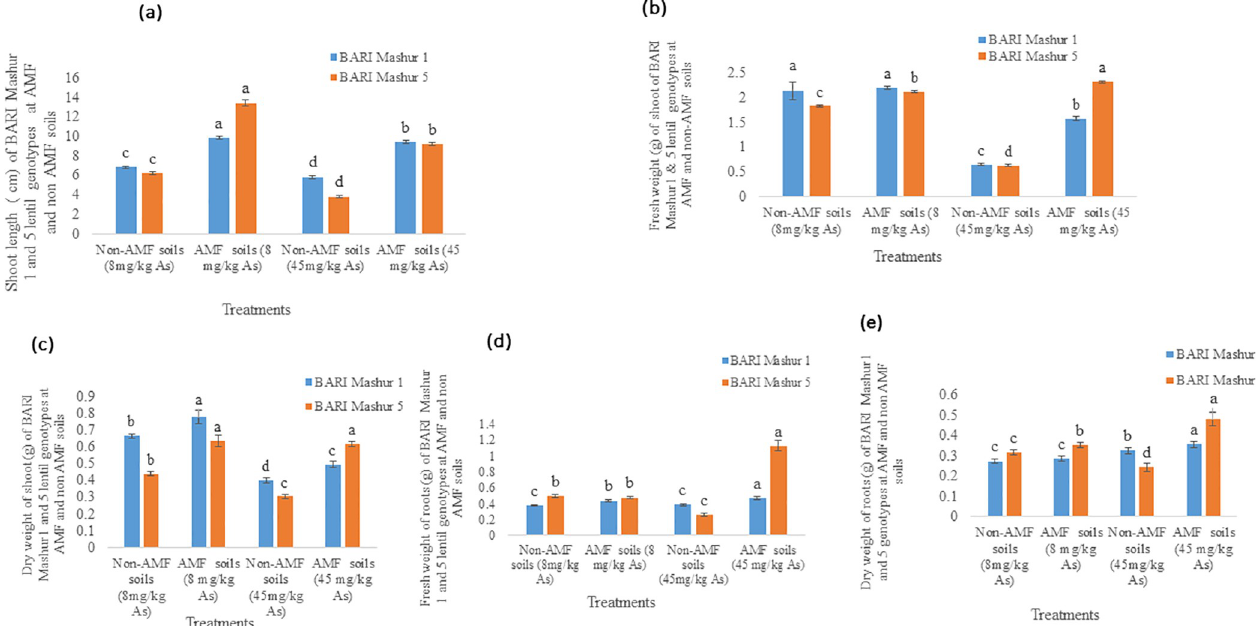
Fig 2. Effect of Arbuscular Mycorrhizal Fungus (AMF) on a) shoot length (Mean ± SEM), b) fresh weight of shoot (Mean ± SEM), c) dry weight of shoot (Mean ± SEM), d) fresh weight of roots (Mean ± SEM), e) dry weight of roots (Mean ± SEM) at arsenic treated BARI Mashur 1 & 5 lentil genotypes. Means denoted by different letters under the same As level indicate significant difference at 0.1% level of